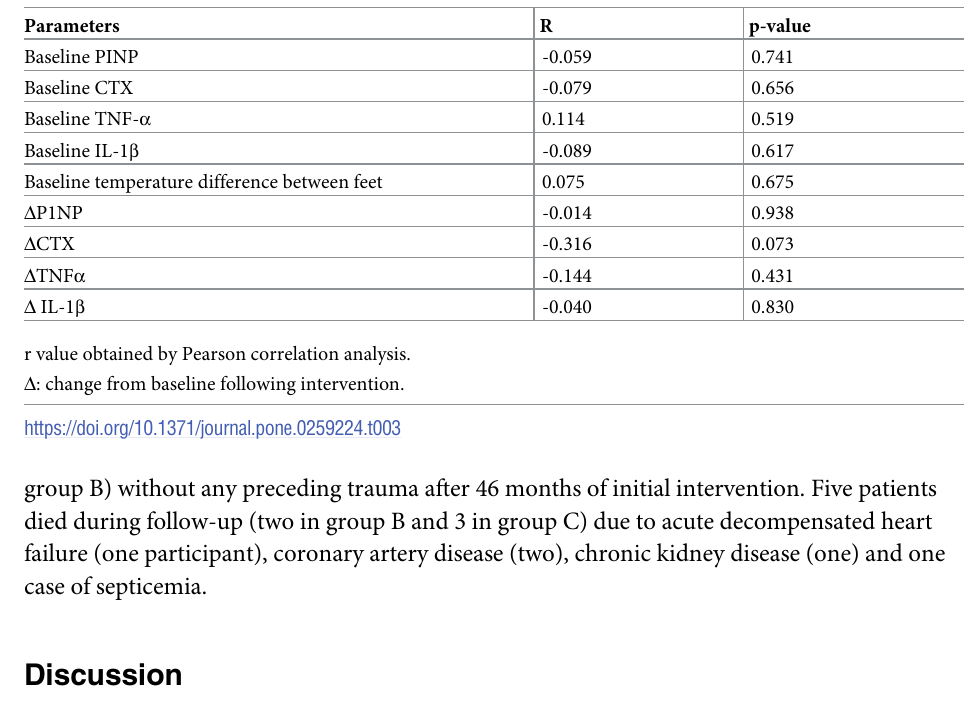
Table 3. Correlation analysis between change in the foot mineral content with baseline inflammatory cytokines, bone turnover marker and their change at six month following intervention. Parameters